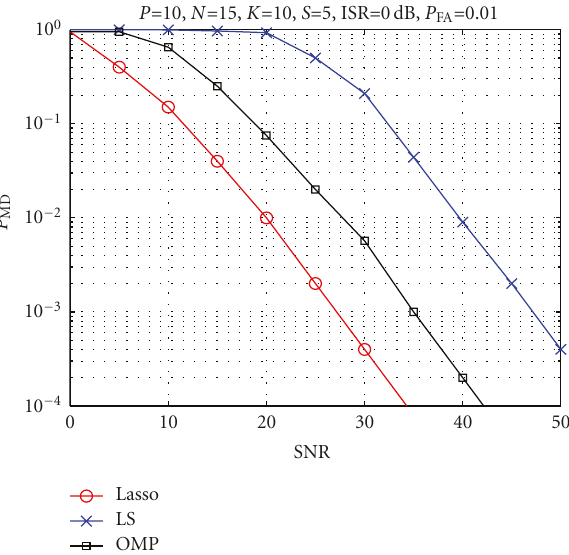
Figure 6: Normalized mean-square error of the composite channel versus SNR for underdeterminate case (asynchronous system with multipath fading channel and known K ).